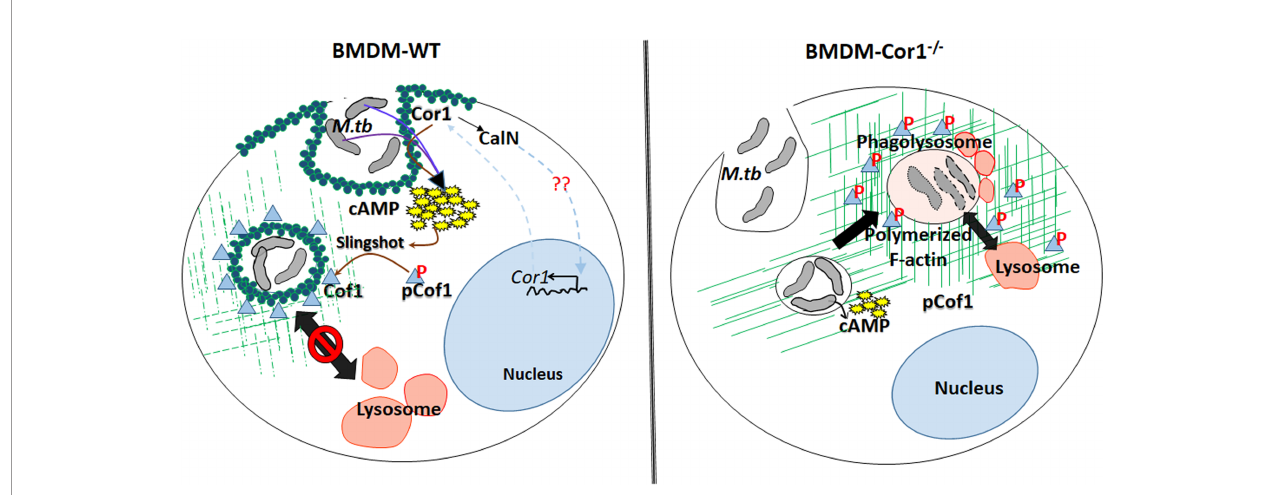
FIGURE 7 | Schematic representation of Cor1-mediated increase of intracellular cAMP upon mycobacterial infection leading to activation of the phosphatase Slingshot and thereby dephosphorylation mediated activation of Co fi lin1 to induce the depolymerization of F-actin to hinder the phagosome maturation and the absence of such pathway in Cor1 -/-